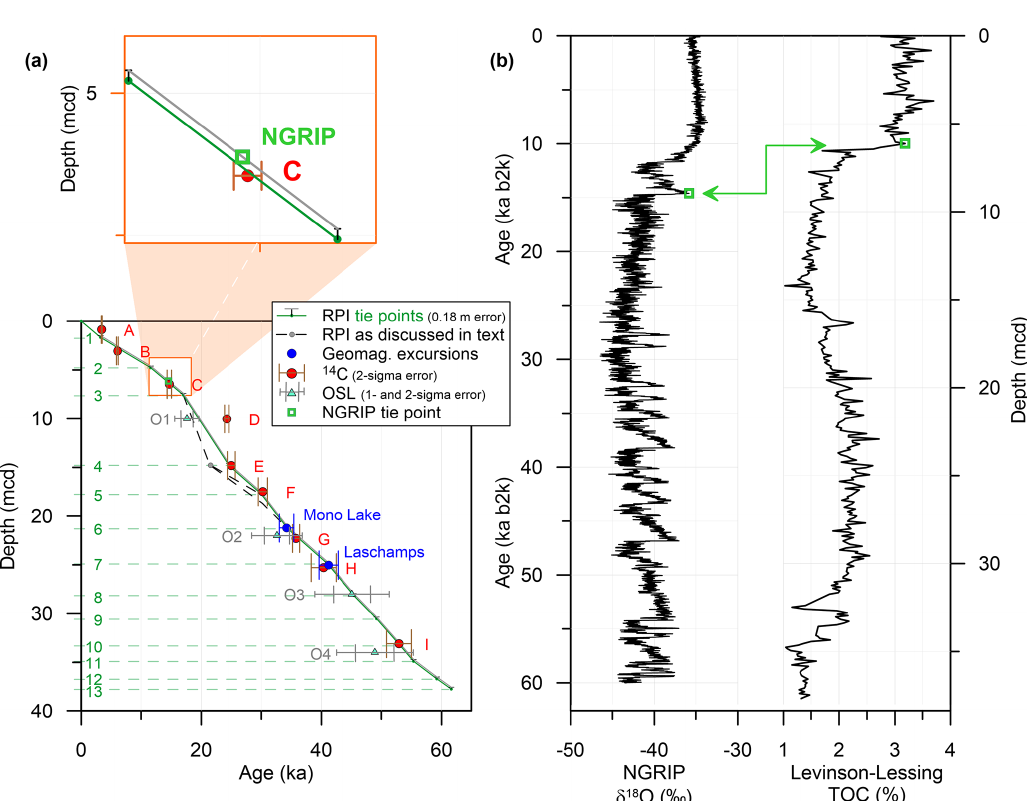
Figure 8. (a) Age–depth model of the core composite Co1401. Ages of the geomagnetic excursions shown after Laj et al. (2014). The grey line represents the age–depth relationship resulting of a constant lock-in depth of 18cm. The age of the NGRIP tie point results from the comparison of δ 18 O vs. age and TOC of Co1401 vs. depth (b) . Its age is recalculated to BP